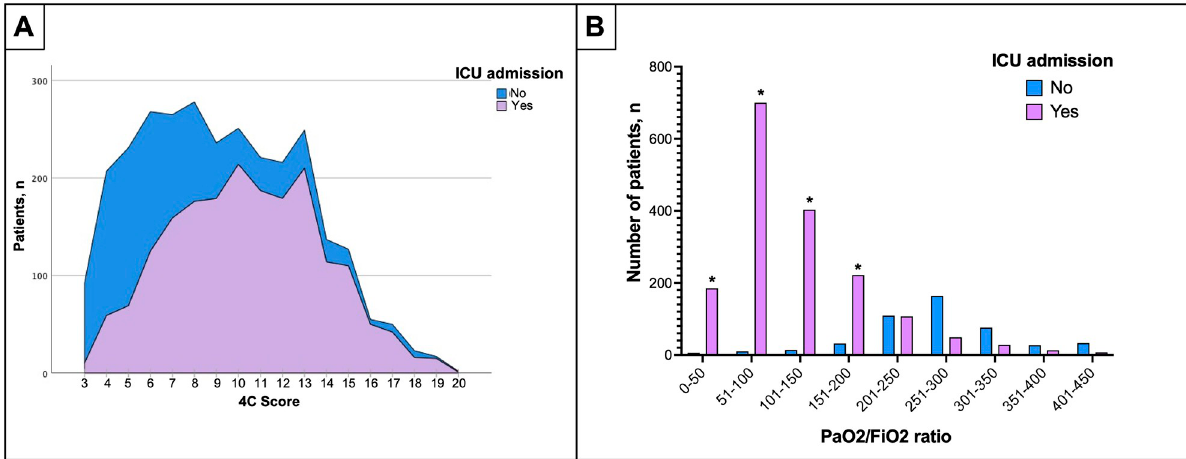
Fig 2. (A) Correlation between the 4C score and the ICU admission rate. This figure compares the number of patients admitted to the ICU (Y-axis) and their punctuation in the 4C score (X-axis). In purple, the patients were admitted to the ICU, and in blue, patients were not admitted. The ICU admission rate increases as the 4C score do. In contrast, most patients rated with 4C scores of 6 or less were more frequently treated outside the ICU. (B) Comparison between PaO2/FiO2 ratio and the number of patients admitted to ICU. This figure compares the number of patients admitted to ICU in purple columns the number of patients who were not admitted to the ICU in blue columns. Patients with a low PaO2/FiO2 ratio were the most admitted to